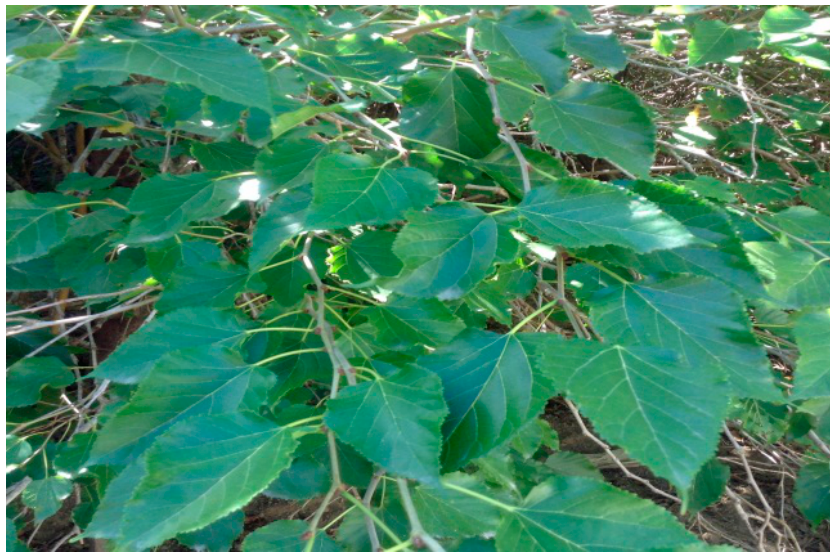
Figure 1. Picture of Mulberry trees leaves.